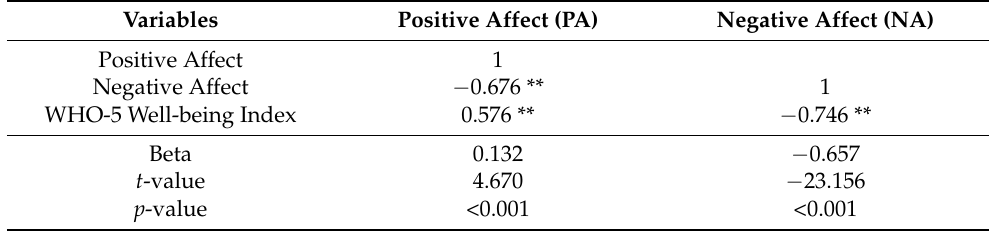
Table 4. Relationship between WHO-5 Well-being Measure and I-PANAS-SF Measure.